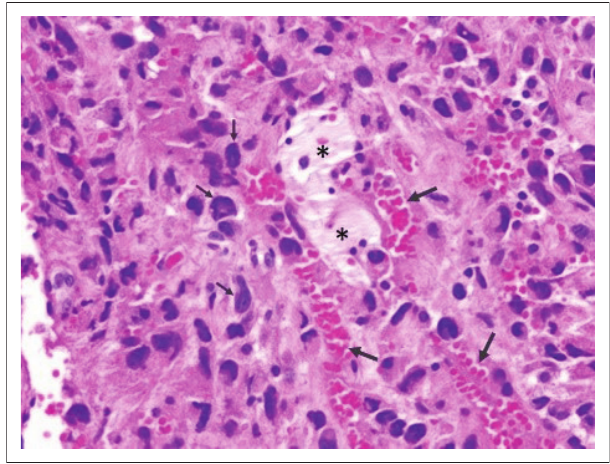
FIGURE 3: Microscopic examination demonstrated high-grade malignant cells (small arrows) with massive haemorrhage (large arrows) and necrosis